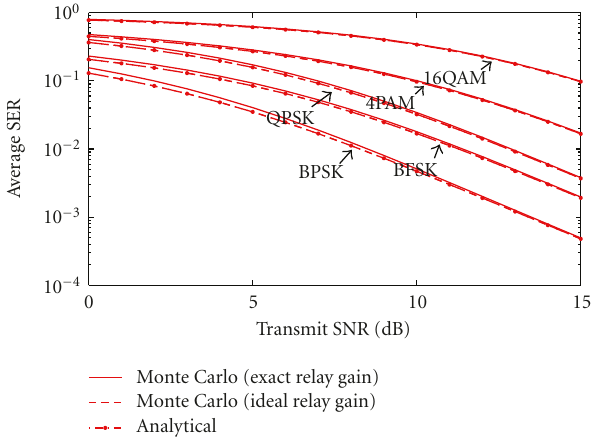
Figure 3: Average SER of the system with di ff erent modulation schemes.